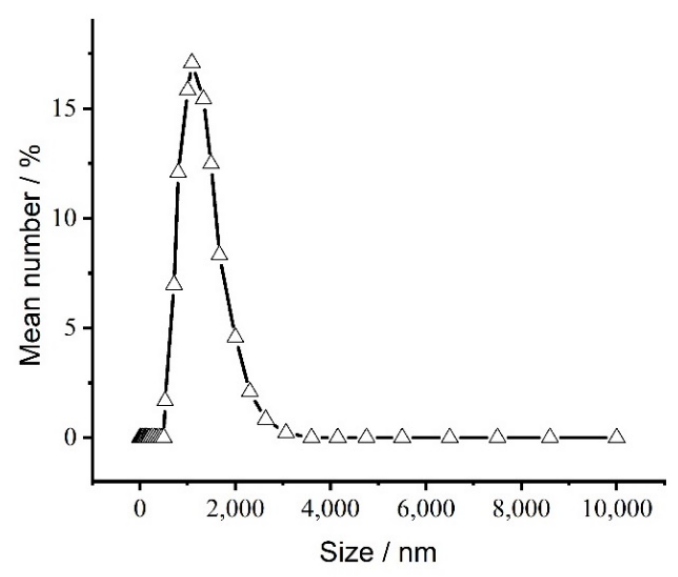
Figure 2. Particle size distribution of the freeze-dried microspheres.